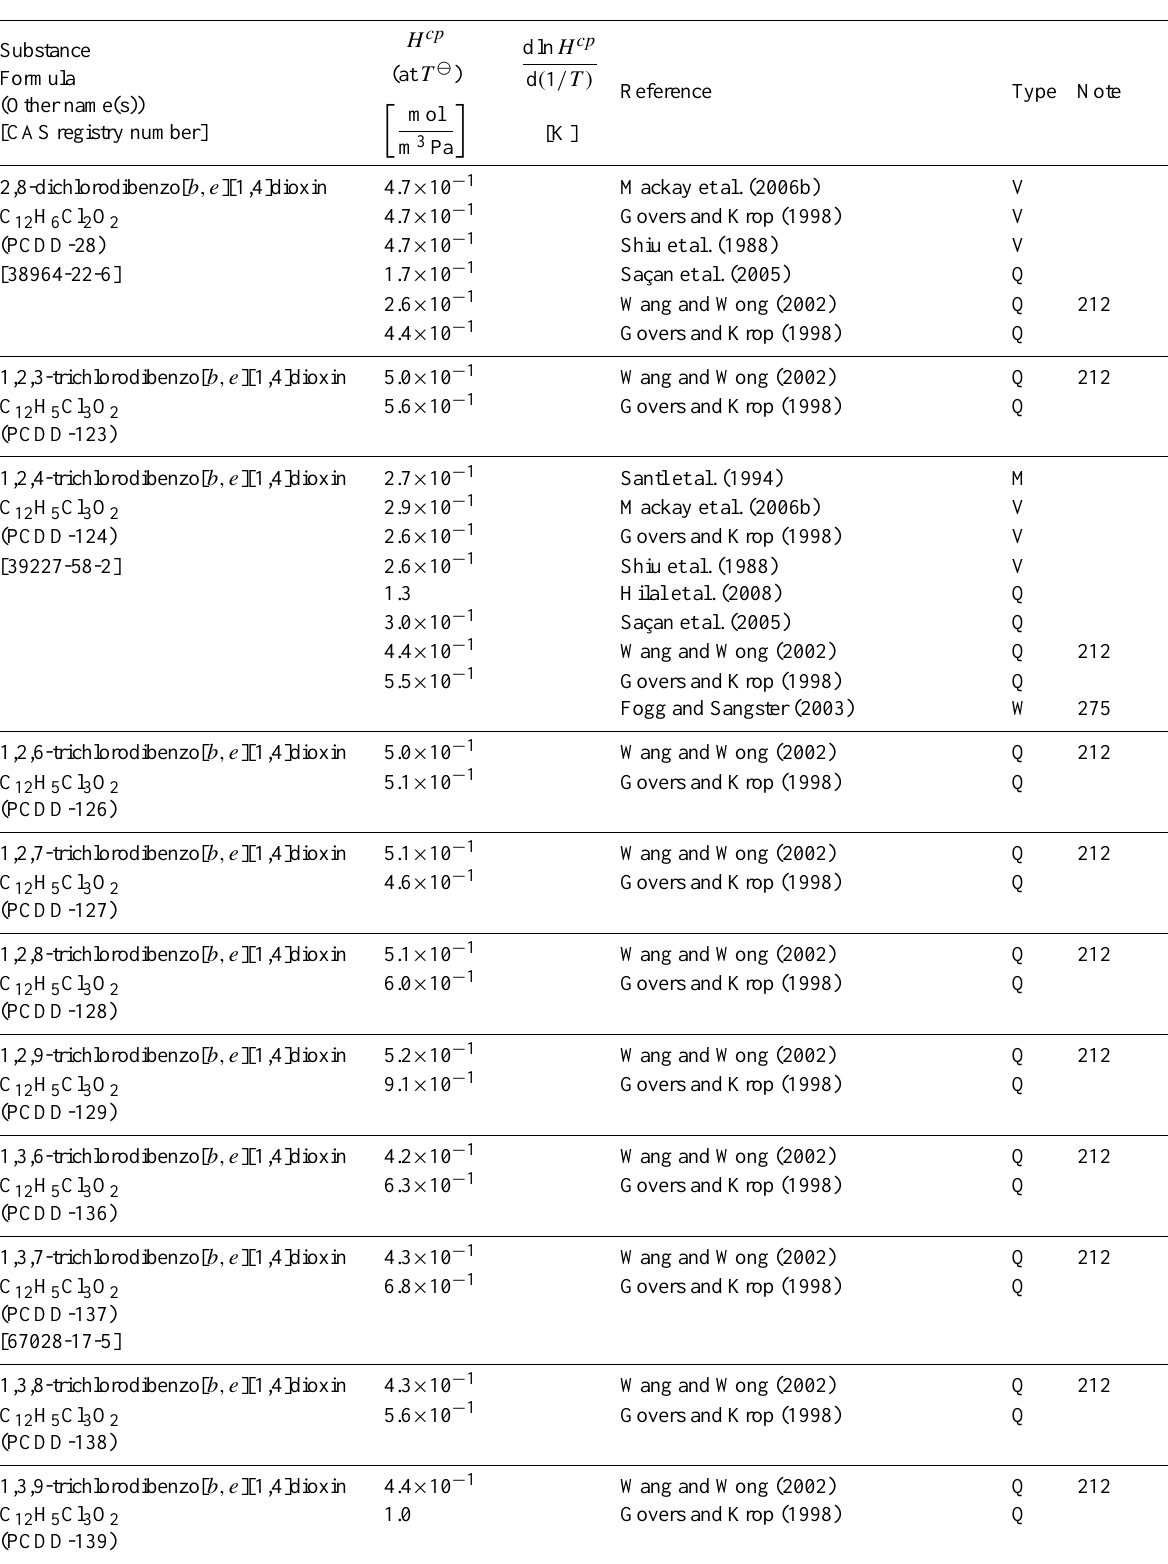
Table 6: Henry’s law constants for water as solvent